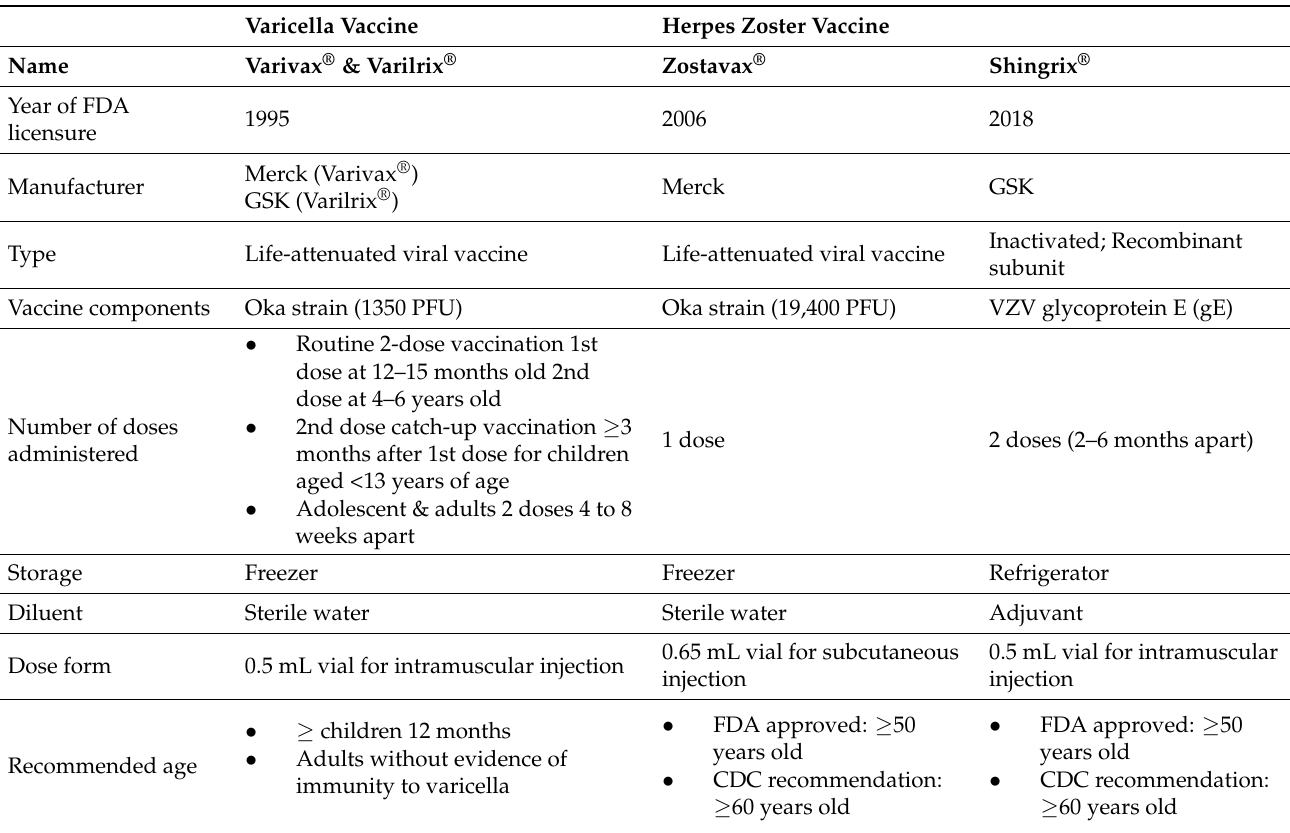
Table 1. Vaccines available against varicella-zoster virus. Comparative characteristics of the available varicella zoster and herpes zoster